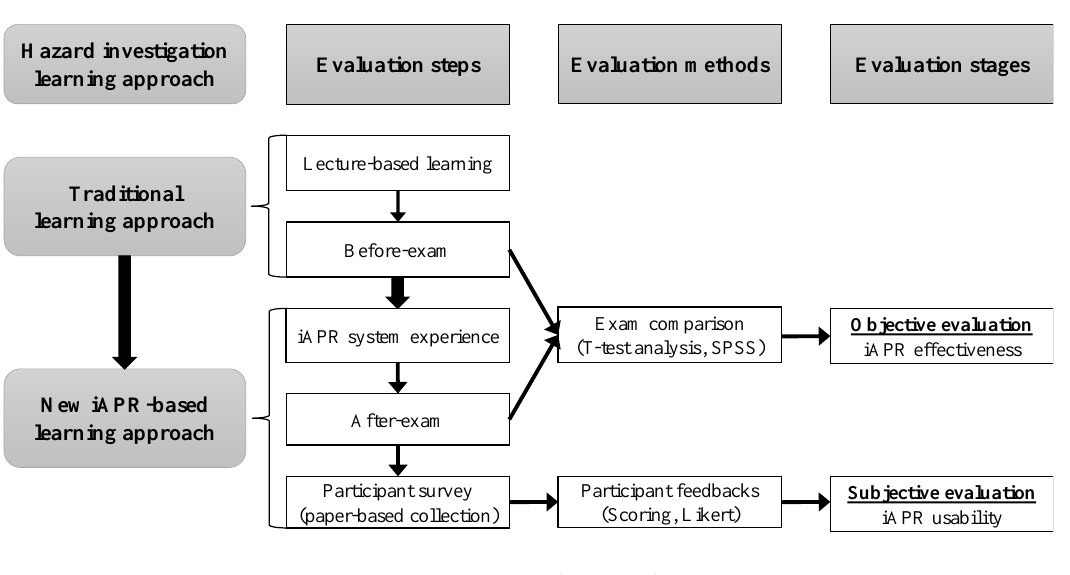
Figure 5. System evaluation